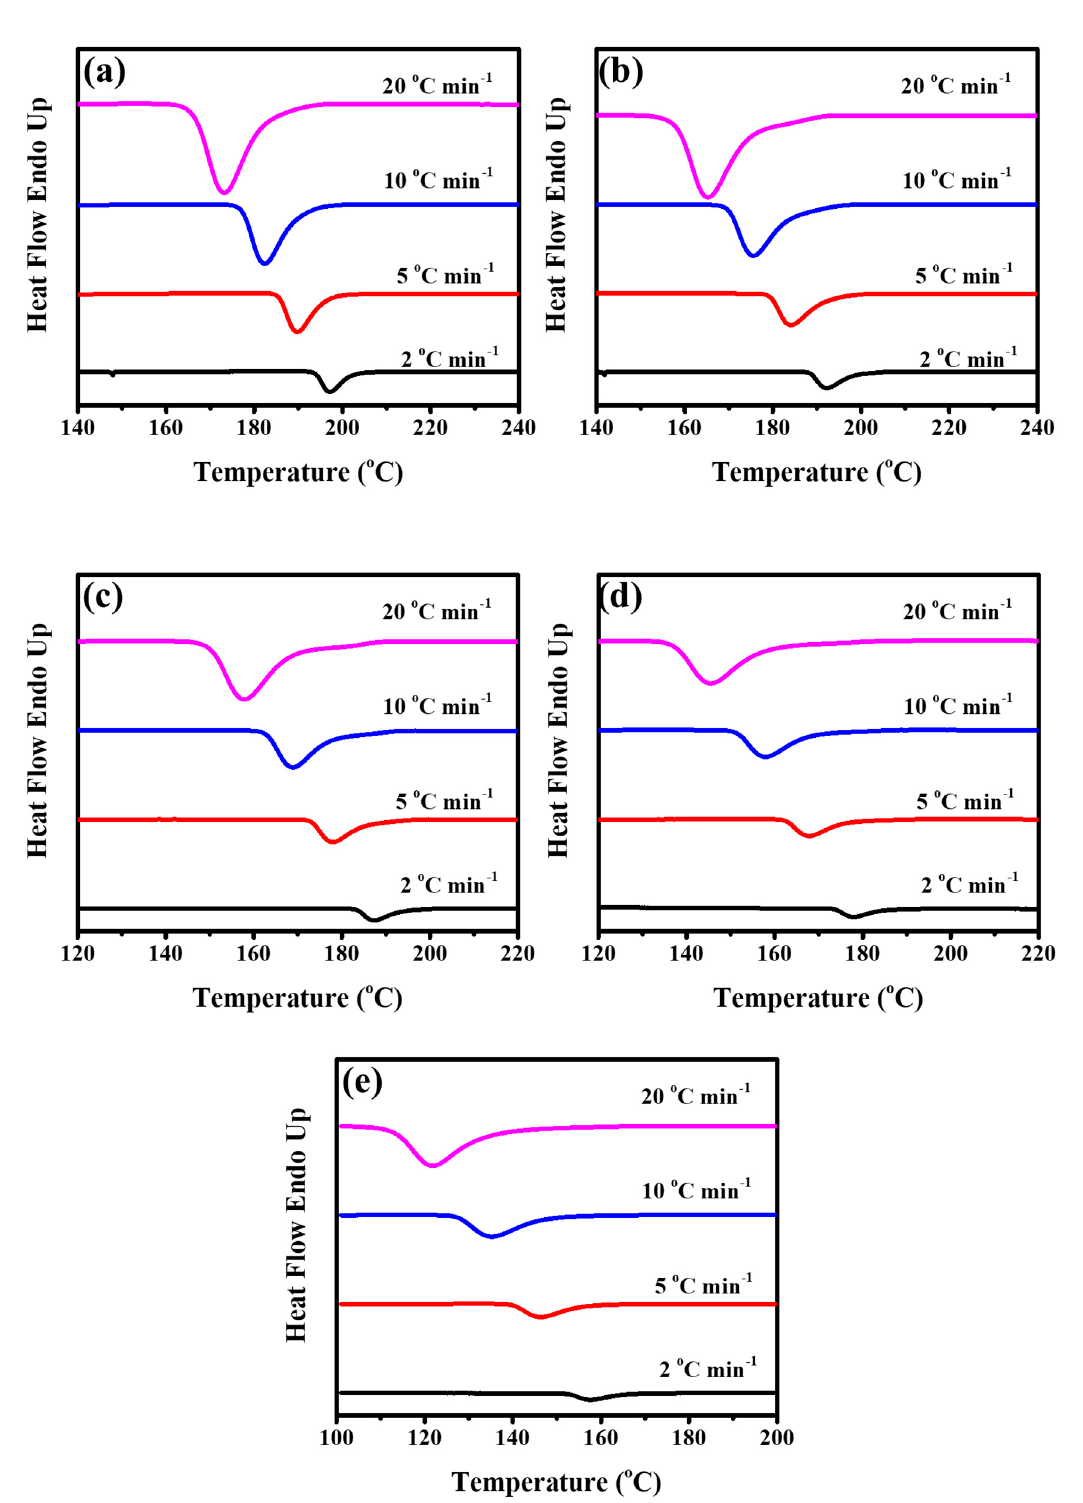
Figure 6. DSC curves of PBT- co -PTMEG copolymers in cooling process at 2, 5, 10, and 20 °C min − 1 : ( a ) PBT, ( b ) PBT- co -PTMEG-10, ( c ) PBT- co -PTMEG-20, ( d ) PBT- co -PTMEG-30, and ( e ) PBT- co -PTMEG-40.